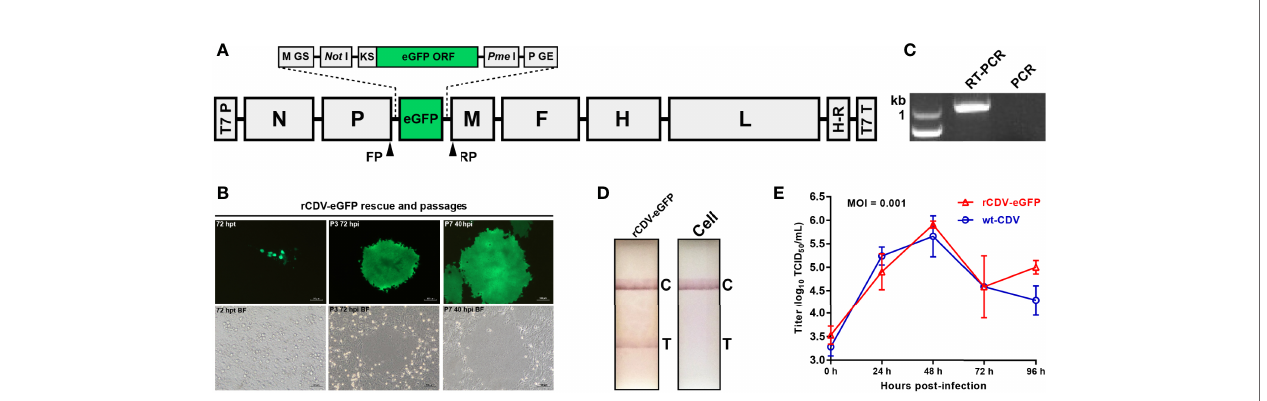
FIGURE 1 | Construction, identi fi cation and characterization of rCDV-eGFP. Schematic representation of rCDV-eGFP cDNA clone (A) . The proportion of elements does not exactly match them. GS, gene start; GE, gene end; KS, Kozak sequence; ORF, open reading frame; T7 P, T7 promoter; H-R, hepatitis delta virus ribozyme; T7 T, T7 terminator. Forward primer (FP)- and reverse primer (RP)-targeted sites are marked with arrowheads. Rescue and passaging of rCDV-eGFP (B) . BF, bright fi eld. Detection of P7 rCDV-eGFP by RT-PCR (C) . PCR is designed as a control using the same primers. Detection of rCDV-eGFP- and non-infected cell cultures by test strips (D) . T, test; C, control. Multi-step growth curves of the P7 rCDV-eGFP and the wt-CDV in VDS cells during 96-hpi period (E)